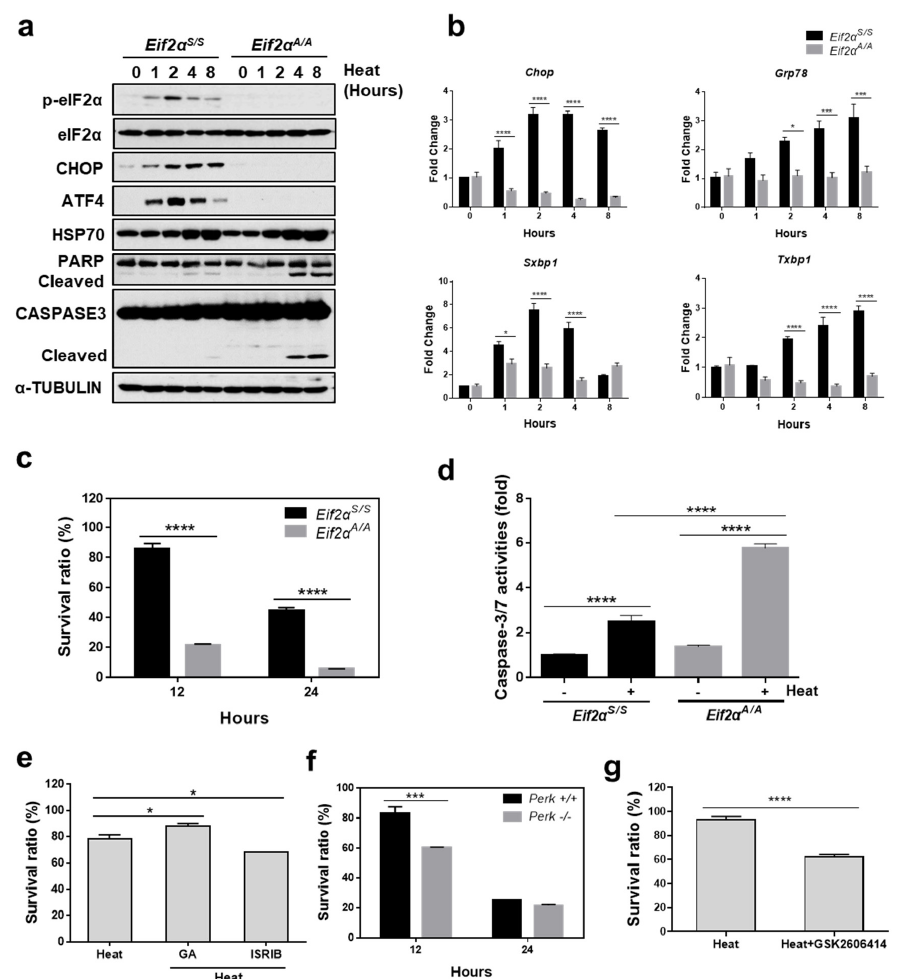
Figure 4. eIF2 α phosphorylation is required to protect cells from heat stress-mediated death. ( a ) Protein expression was measured under conditions of hyperthermia. Cell lysates were collected from Eif2 α S/S and Eif2 α A/A MEFs at indicated times for western blot analysis following incubation at 42 ◦ C. ( b ) Quantitative RT-PCR was performed using total RNA extracted from Eif2 α S/S and Eif2 α A/A MEFs which were incubated at 42 ◦ C for indicated time periods. Data are presented as means ± SEM (n = 3 independent experiments). ( c ) Cell viability was measured in Eif2 α S/S and Eif2 α A/A MEFs which were incubated at 42 ◦ C for indicated times. ( d ) Caspase 3/7 activity was detected in Eif2 α S/S and Eif2 α A/A MEFs which were incubated at 42 ◦ C for 12 h. ( e ) Cell viability was measured in MEFs which were incubated at 42 ◦ C for indicated time periods in the presence or absence of guanabenz (GA, 1 µ M) or ISRIB (5 µ M). ( f ) Cell viability was measured in Perk +/+ and Perk − / − MEFs which were incubated at 42 ◦ C for 12 and 24 h. ( g ) Cell viability was measured in MEFs which were incubated at 42 ◦ C for 12 h in the presence or absence of GSK2606414 (100 nM). * p < 0.05; *** p < 0.001; **** p <